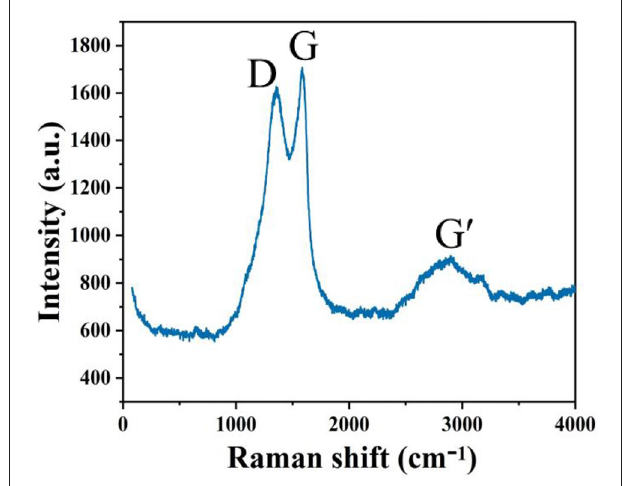
FIGURE 2 | Raman spectrum of GQDs in an aqueous